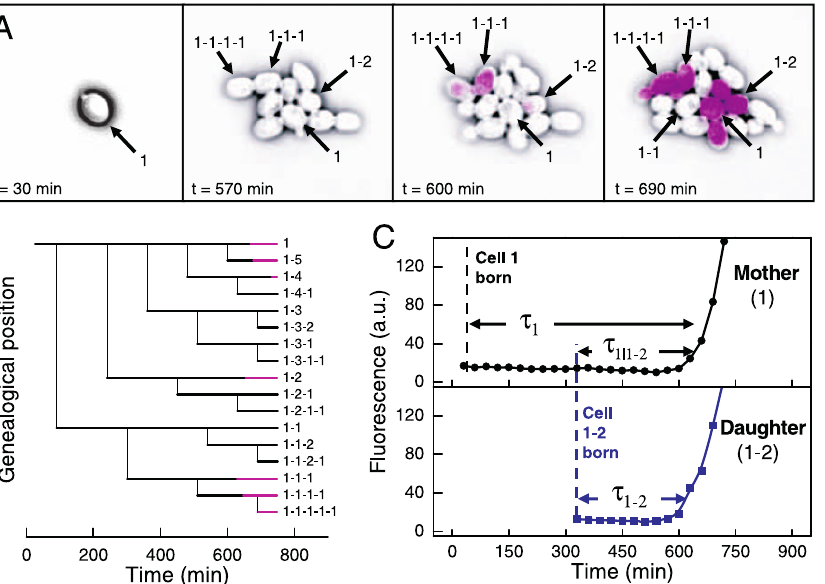
Figure 2. A Genealogical Switching History We designate the first cell in each movie cell 1 and sequential daughters of that cell 1–1, 1–2, 1–3. These daughter cells bud in turn, giving rise to cells 1- 1-1, 1-1-2, 1-2-1, etc. (A) As in Figure 1, an initially OFF cell grows into a variegated micro-colony. Beginning at 600 min, or 4 generations, several cells fluoresce almost simultaneously. This includes the mother-daughter pairs (1,1–2) and (1-1-1,1-1-1–1). Conspicuously, cell 1–1 does not switch for the duration of our observation, even though its mother, daughter, and closest sibling all do. (B) The family tree for colony in (A). Black lines indicate cells in the OFF state, whereas pink lines represent cells after they have switched to the ON state. (C) Fluorescent time courses for mother cell 1 and her daughter 1–2, showing each as they switch into the ON state. The marginal switch times s 1 and s 1–2 , run from cell birth until the beginning of the increase in fluorescence and do not depend on any other cells. The period labeled s 1 j 1–2 runs between the birth of cell 1–2 and the fluorescence of cell 1 and is an example of a conditional switch